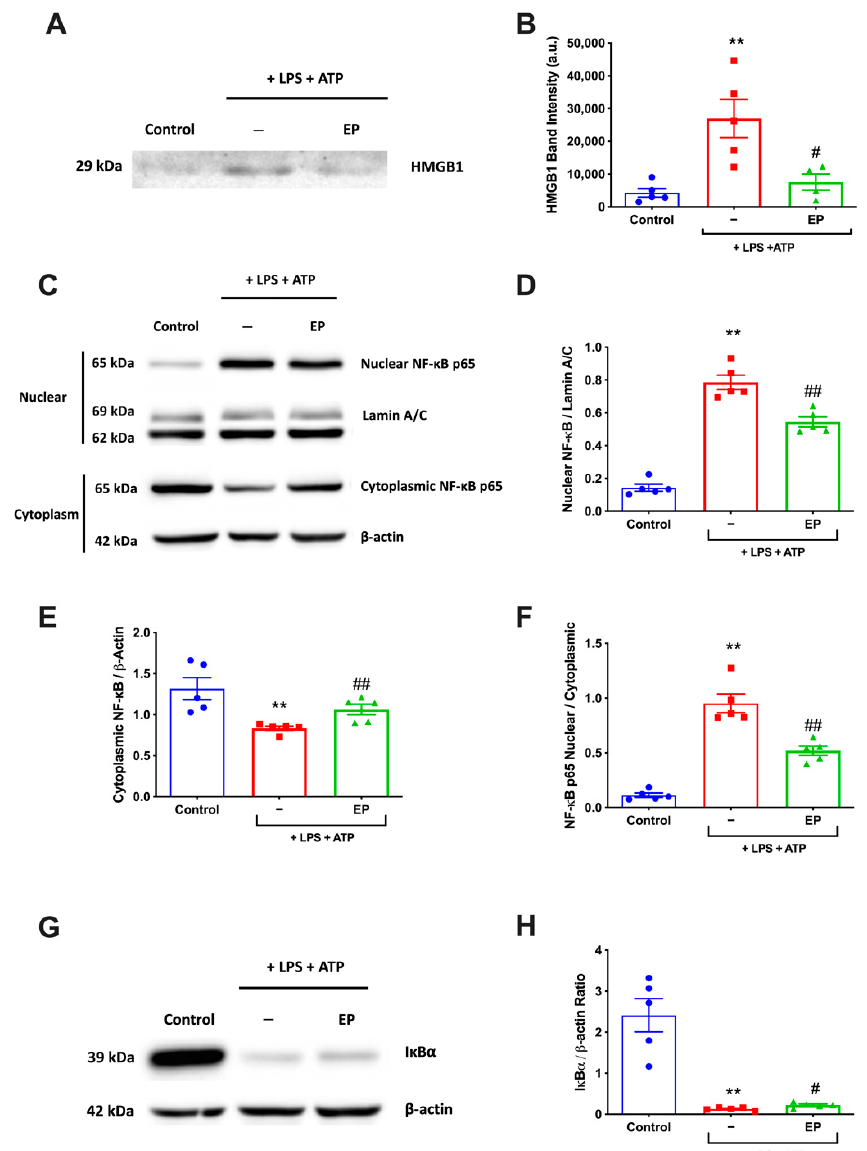
Figure 5. EP suppressed HMGB1 levels and inhibited activation of NF- κ B. N9 microglial cells were pretreated with EP (10 mM) for one hour, then treated with LPS (1 µ g) for 30 min. ( A , B ) EP reduced LPS- and ATP-induced HMGB1 levels. ( C , D ) EP pre-treatment reduced phosphorylation of p65 subunit of NF- κ B. ( C , E ) EP pre-treatment significantly reduced the p50 subunit of NF- κ B. ( F ) EP rescued LPS and ATP induced an increase of nuclear/cytoplasmic ratio of NF- κ B p65 subunit. ( G , H ) EP pre-treatment increased expression of I κ B α , which was downregulated after LPS and ATP induction. Data are presented as mean ± S.E.M, n = 5. ** p < 0.01 compared to control and # p < 0.05 and ## p < 0.01 compared to LPS-induced